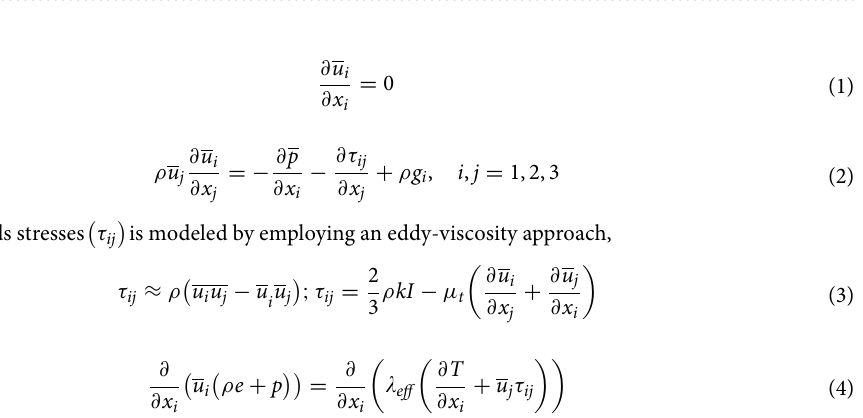
Table 2. Simulation scenarios. *During this aim, the equalizer is the only outlet exhaust. **During this aim, all the windows are assumed to be